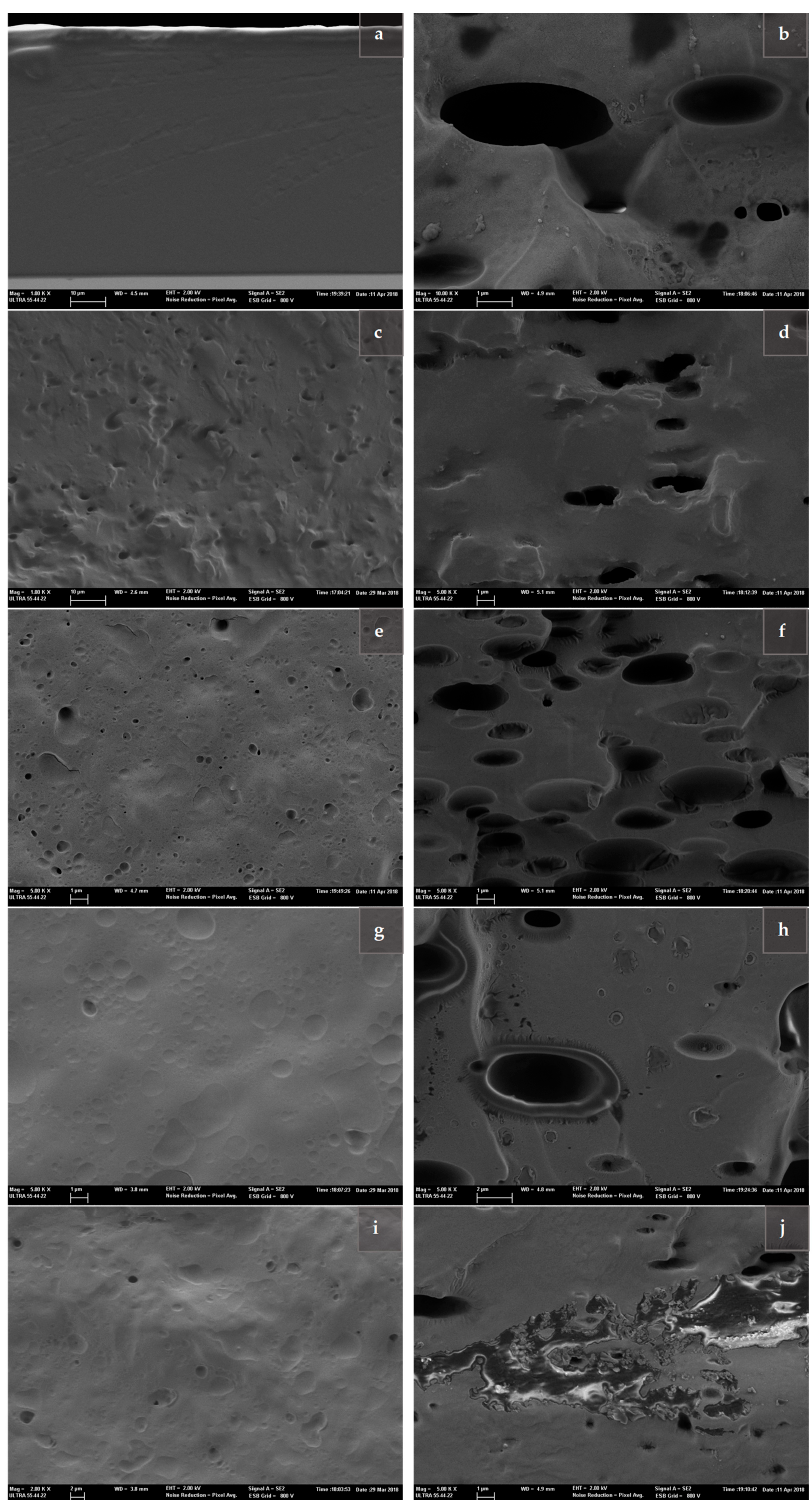
Figure 3. FESEM micrographs of the cross-section of F-PVA and P-PVA films with CA-loaded lipo- somes (CA: LEC: 1:1) using different types of lecithin (soy lecithin enriched in phosphatidylcholine PC (SL-PC), soy lecithin (SL) and sunflower lecithin (SFL)) and the sonication method. ( a ) P-PVA with free CA; ( b ) F-PVA with free CA; ( c ) P-PVA with CA-free SL-PC; ( d ) F-PVA with CA-free SL-PC; ( e ) P-PVA with CA-loaded SL-PC; ( f ) F-PVA with CA-loaded SL-PC; ( g ) P-PVA with CA-loaded SL; ( h ) F-PVA with CA-loaded SL; ( i ) P-PVA with CA-loaded SFL; ( j ) F-PVA with CA-loaded